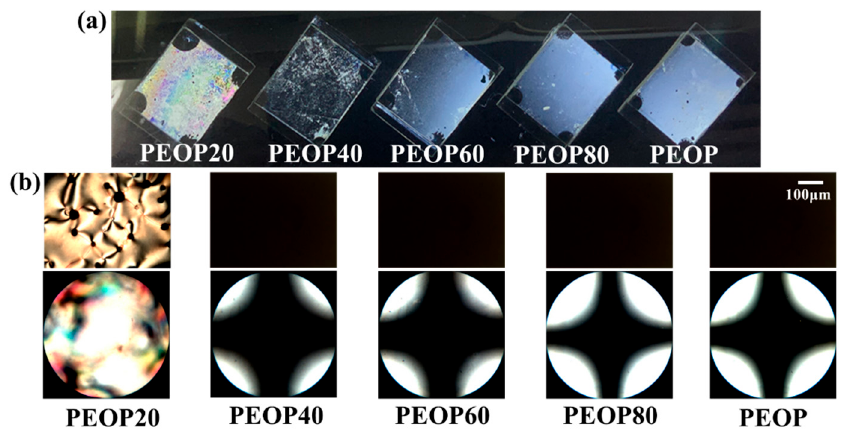
Figure 5. ( a ) Photograph, ( b ) orthoscopic (top) and conoscopic (bottom) polarized optical microscopy (POM) images of the LC cells fabricated with PEOP# (PEOP20, PEOP40, PEOP60, PEOP80, and PEOP).